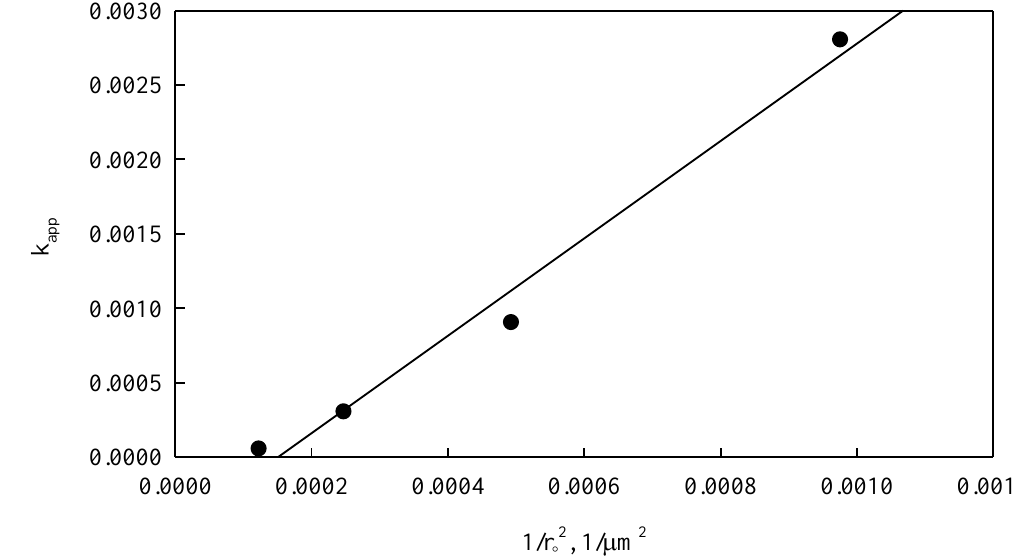
Figure 15. Slag leach kinetics for different particle sizes.